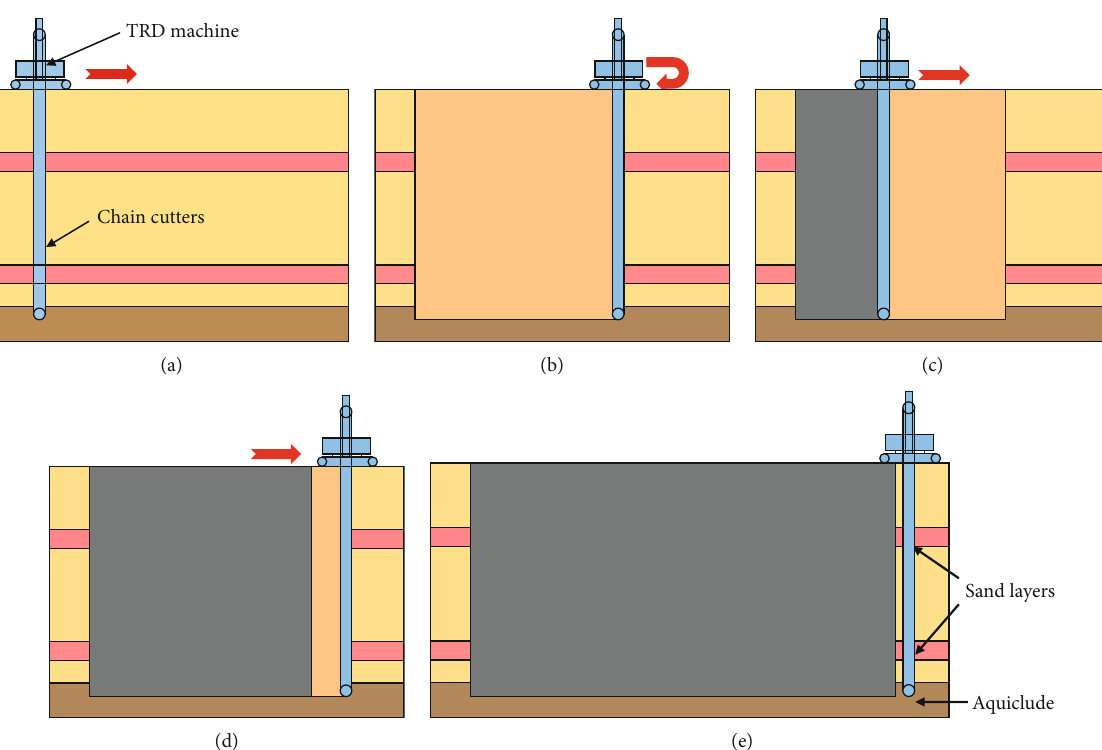
Figure 3: Schematic diagram showing the steps of the TRD method. (a) Insert the saw chain cutters. (b) Cut and mix the soil mass and inject bentonite slurry. (c) Inject cement slurry and mix. (d) Go to the next section. (e) Pull out the cutters after having